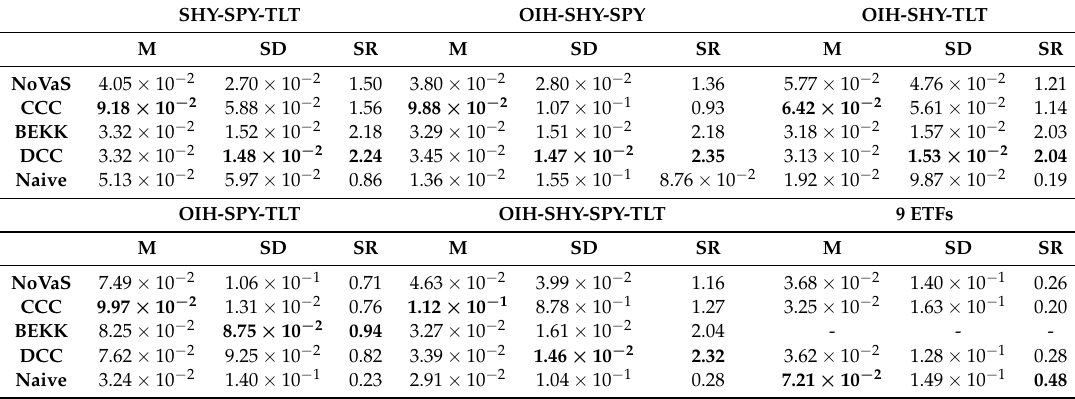
Table 11. Mean (M), standard deviation (SD) and Sharpe ratio (SR) of portfolio returns with monthly rebalancing and with weights computed on 1/3 of available observations.